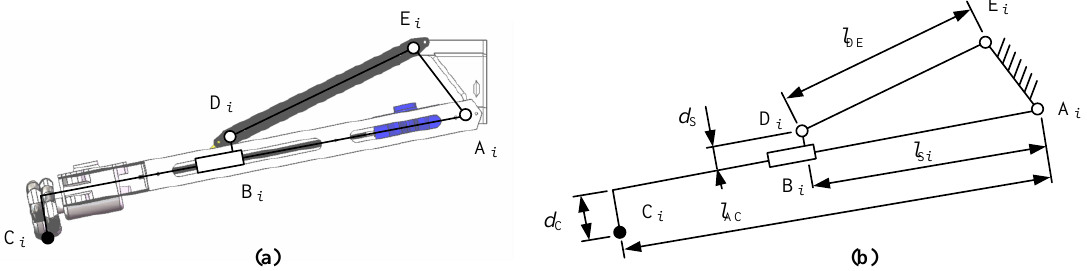
Figure 3. ( a ) Geometry structural and ( b ) dimensions of the limb.